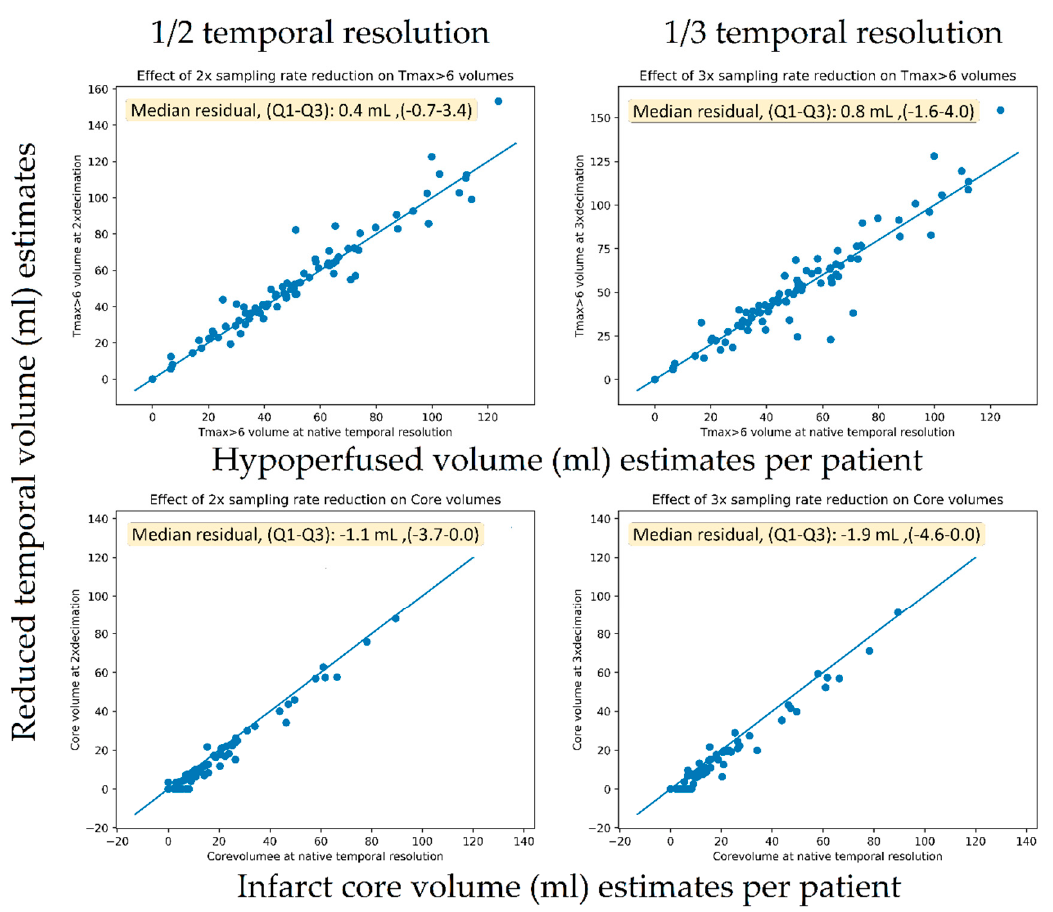
Figure 7. Scatter plots of the original versus temporal reduced volumes for infarct core (lower row) and hypoperfusion (upper row) volume estimates.